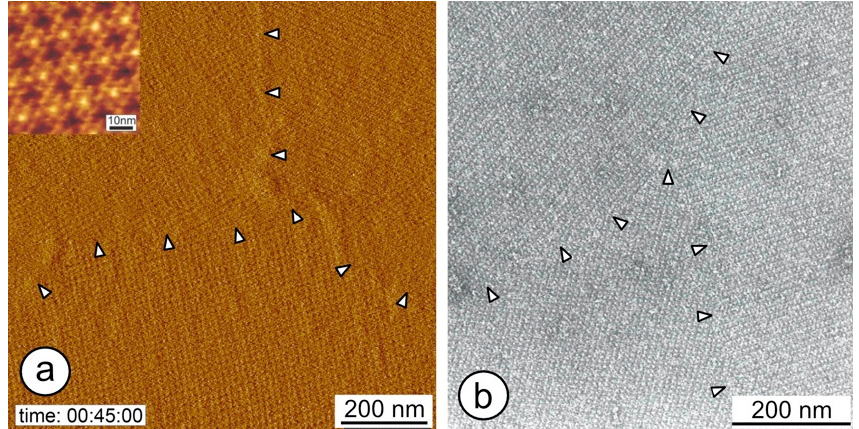
Figure 4. ( a ) AFM image of a mosaic of self-assembled S-layer domains of SbpA on a silicon surface 45 min after injection of the protein into the liquid cell. The inset shows a high-resolution AFM image of SbpA. The square (p4) lattice symmetry is clearly visible (reproduced with permission from Reference [51]; published by Wiley and Sons, 2003). ( b ) TEM micrograph of a negatively stained preparation of crystalline domains of the oblique S-layer lattice of B. coagulans E38-66 reassembled on a poly-L-lysine coated EM-grid (reproduced with permission from Reference [52]; published by the American Society for Microbiology, 1989). The grain boundaries are marked by arrows in both panels.